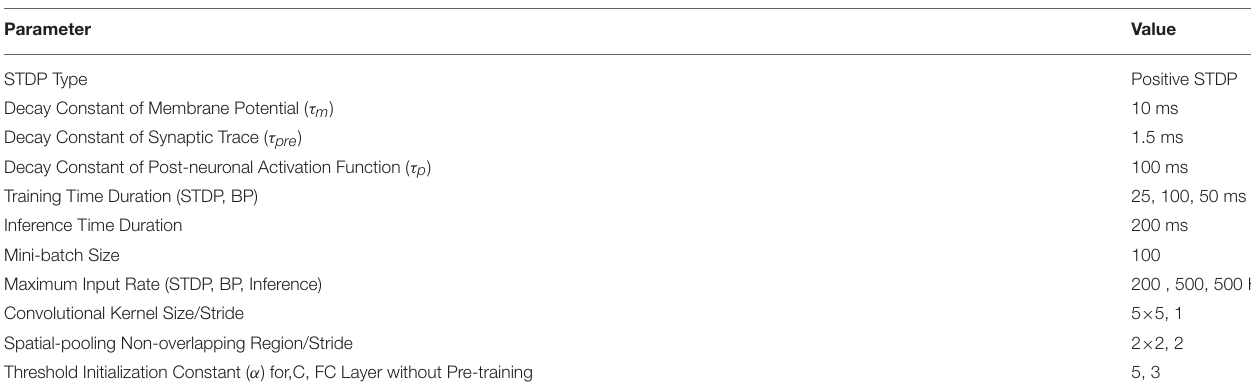
TABLE 1 | Parameters used in the